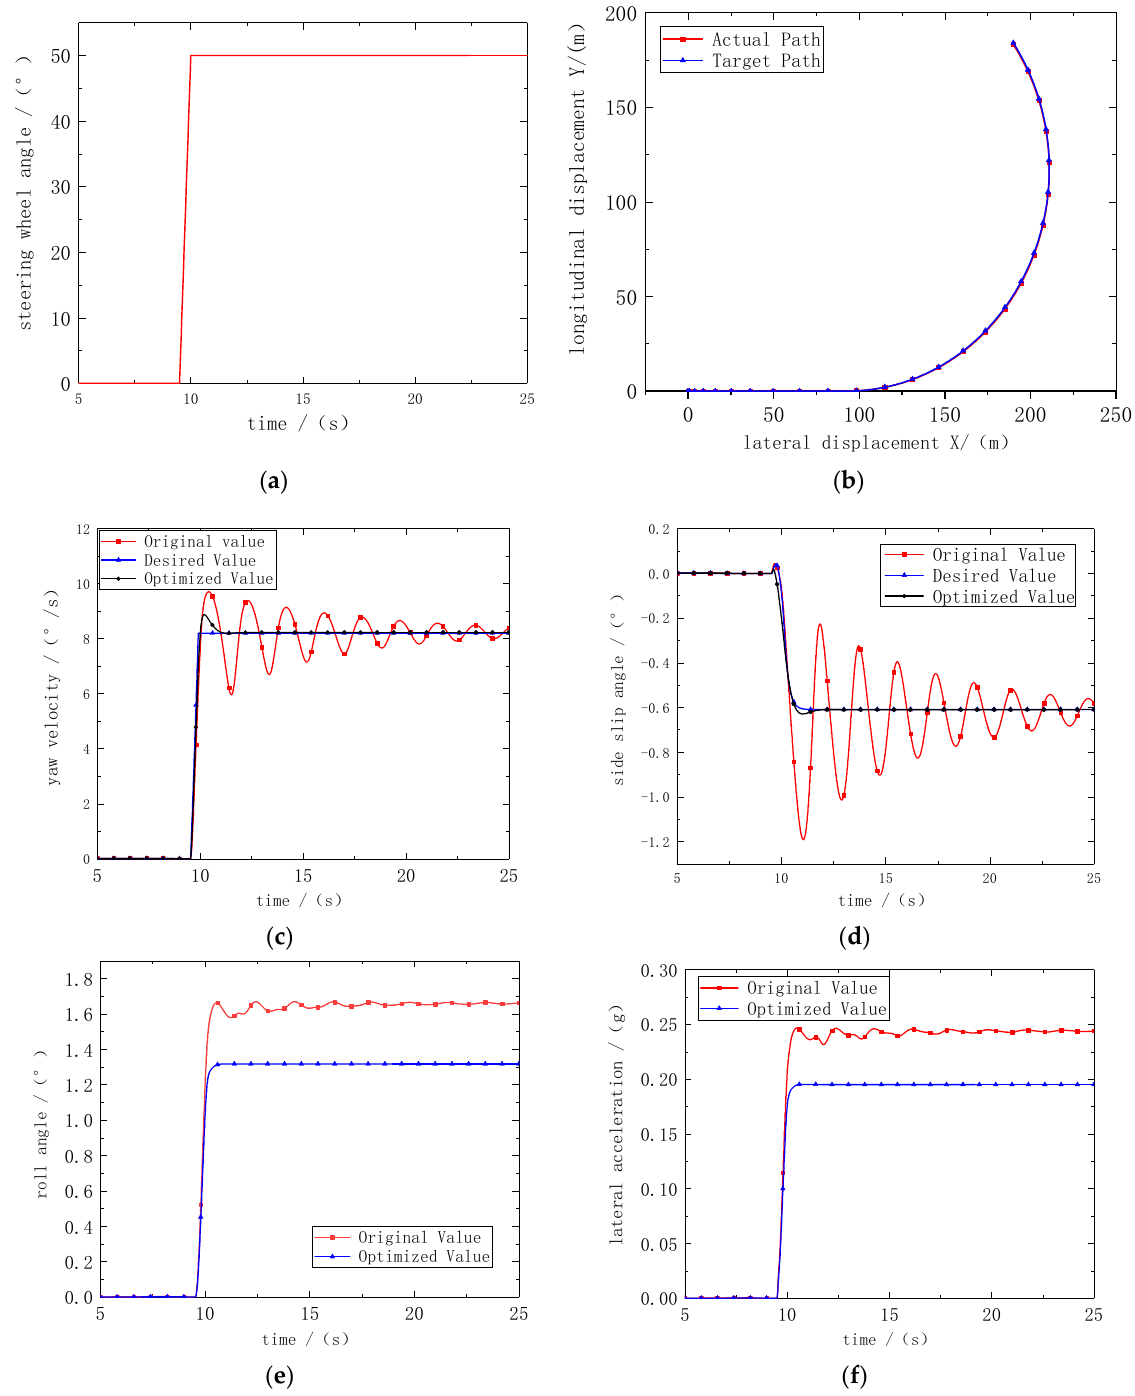
Figure 5. Simulation results of angular step input condition. ( a ) Steering wheel angle. ( b ) Vehicle track. ( c ) Yaw velocity. ( d ) Side slip angle. ( e ) Lateral acceleration. ( f ) Roll angle.